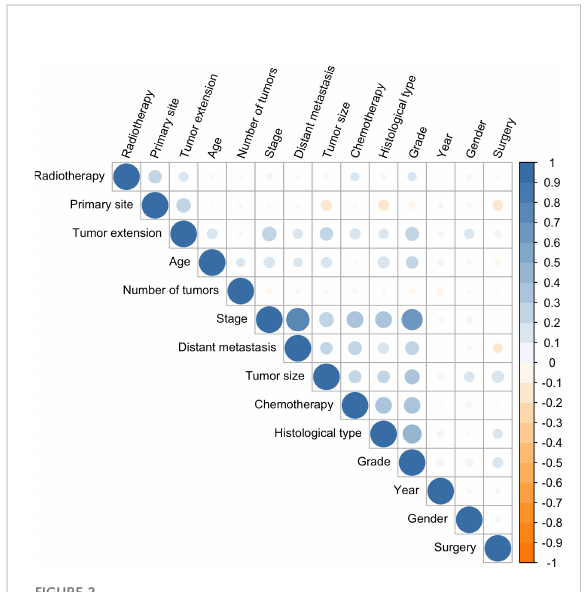
FIGURE 2 Correlation coef fi cients for each pair of variables in the data set. The estimated correlation values are distributed within the range of -1 to +1. They are represented by color depth, with a number closer to either end value implying a stronger negative correlation or positive